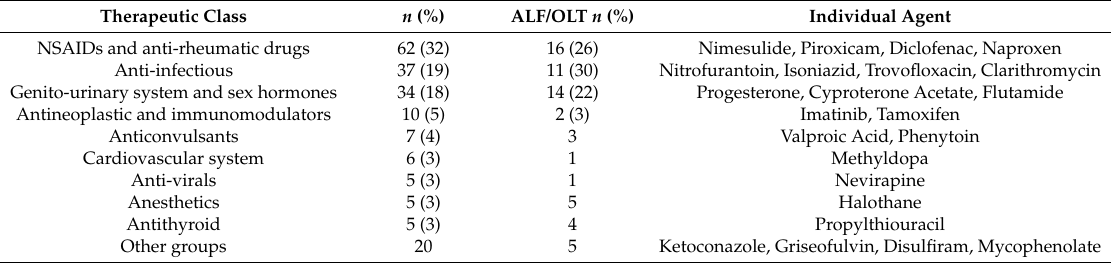
Table 1. Main therapeutic classes and individual agents with progression to ALF (acute liver failure) or OLT (orthotopic liver transplantation) published in Latin America (LA) during 1996–2012 [5]. Therapeutic Class n (%) ALF/OLT n (%) NSAIDs and anti-rheumatic